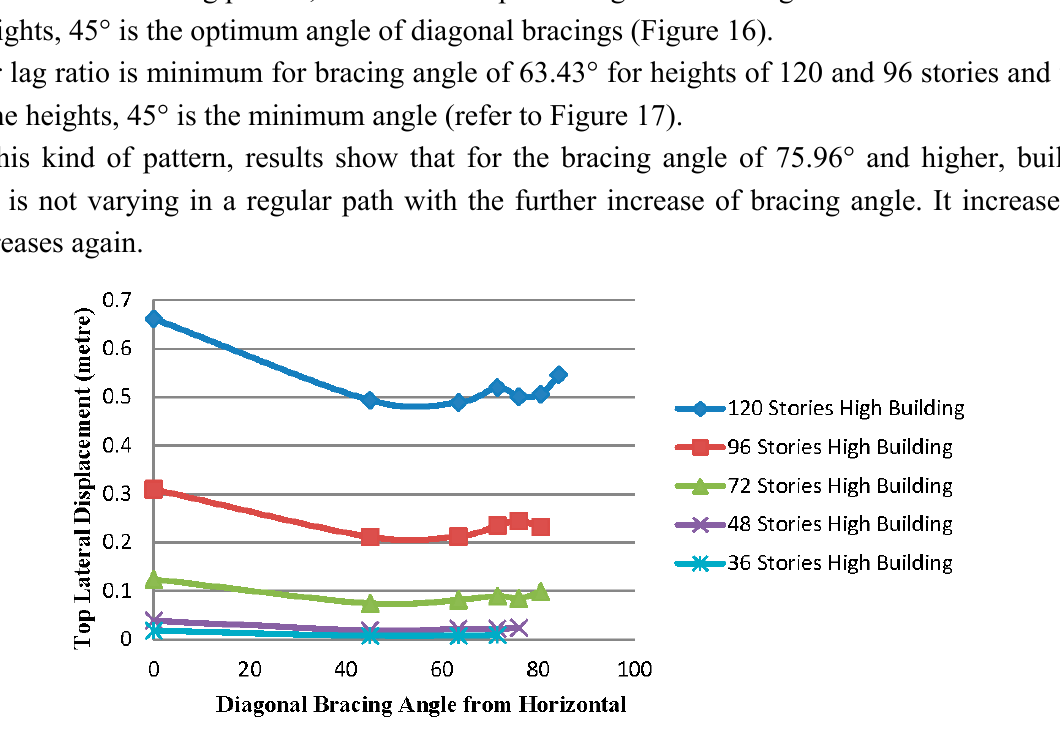
Figure 16. Top lateral deflection vs. varying angle of bracing system for buildings of Model